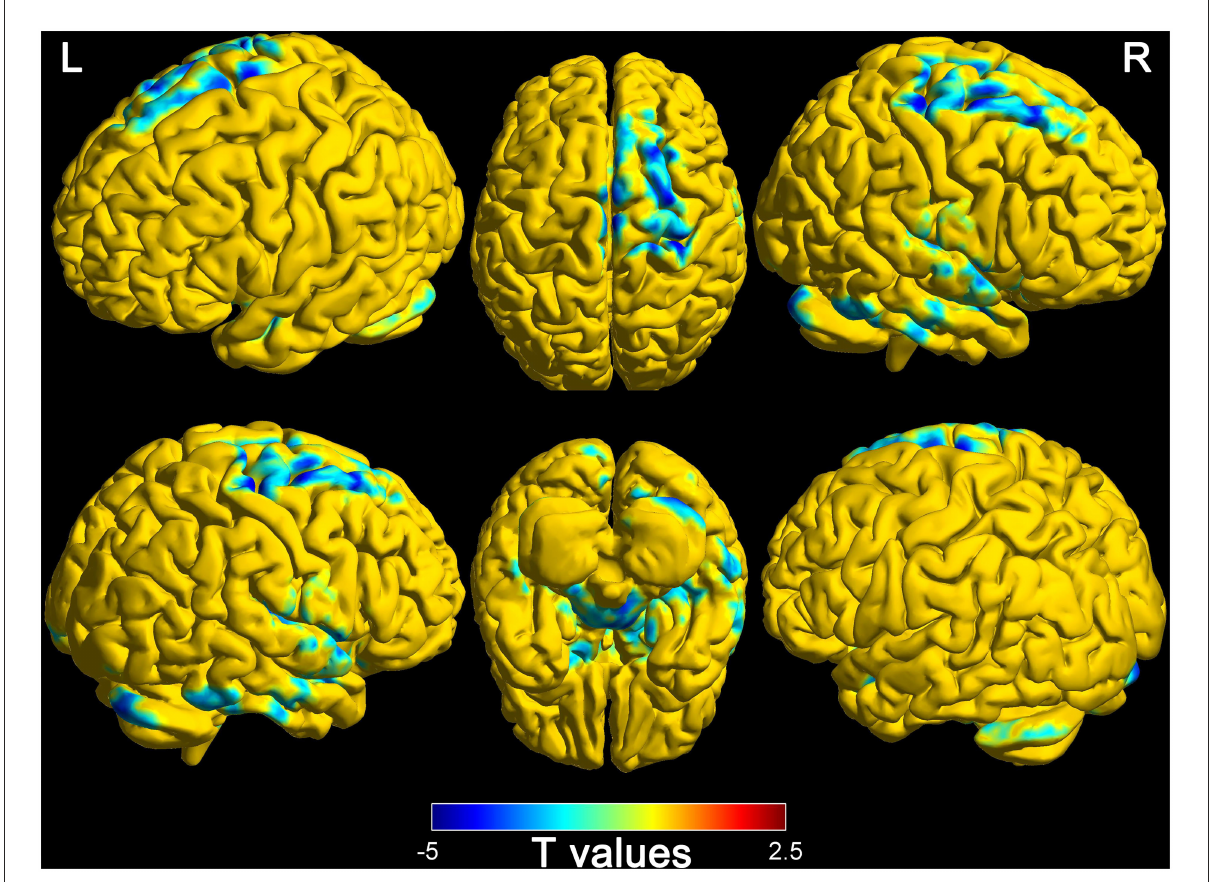
FIGURE3 Differences of functional connectivity (thalamus to whole-brain) between wake and DOC groups (L, left; R,